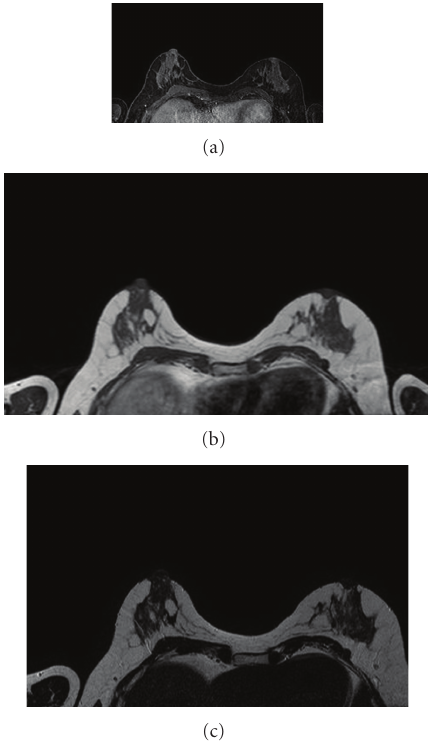
Figure 1: Di ff erent MRI (T1 with fat suppression, T1, T2) with skin intensity level similar to dense tissue intensity